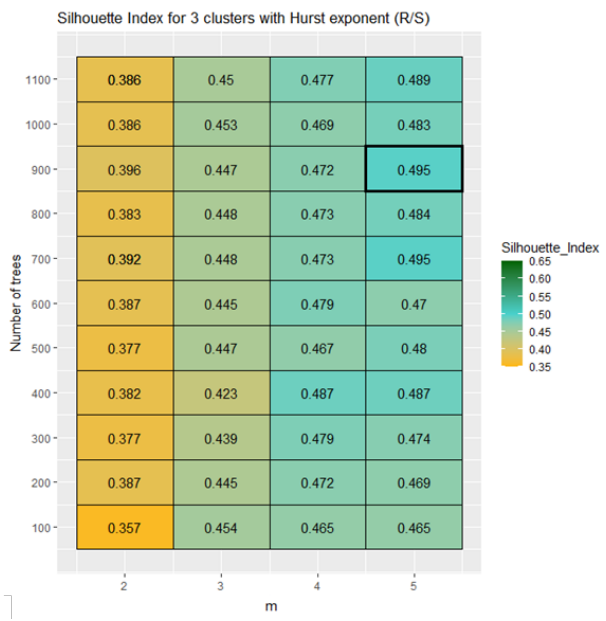
Figure A1. Silhouette indexes for three clusters for URF using Hurst exponent calculated with Rescaled Range method. “ m ” represents the number of predictors tested on each node.